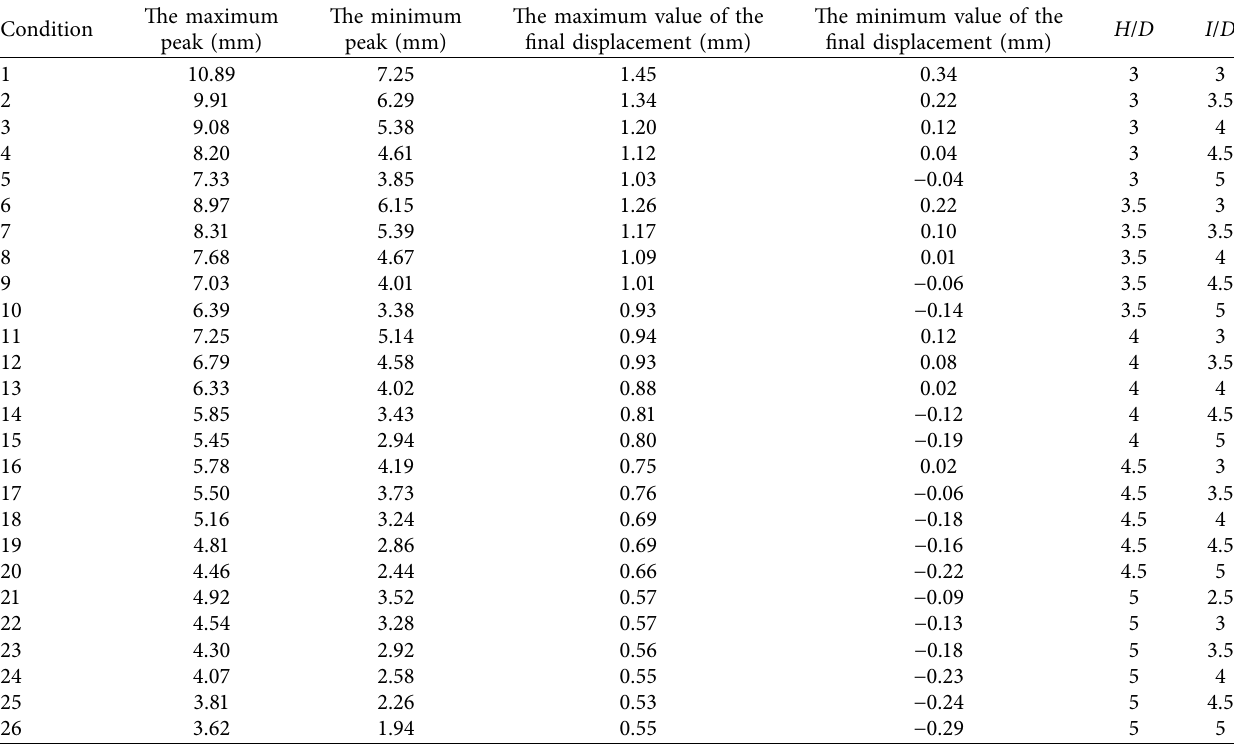
Table 4: Statistics of vertical displacement of each case.